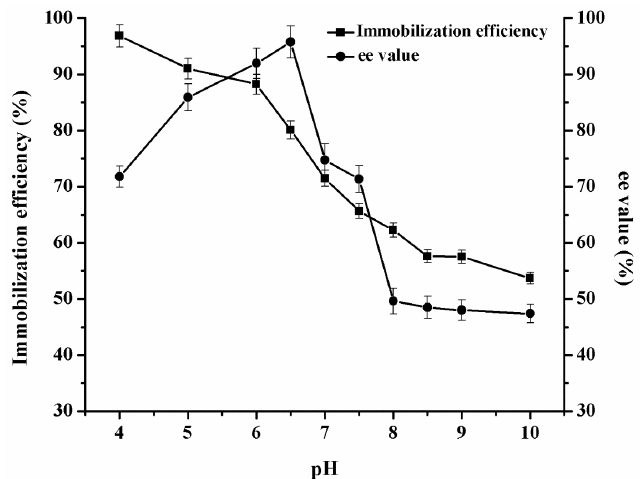
Figure 4. Effects of solution pH values (4–10) on the immobilization efficiency and ee value with enzyme amount ratio of 2.0. (Reaction conditions: 0.02 g immobilized lipase as catalyst, 45 ◦ C, 1